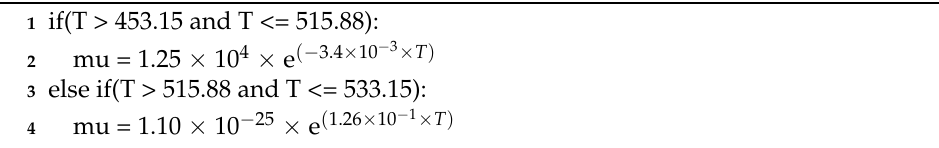
Algorithm 2: Definition of the experimental viscosity